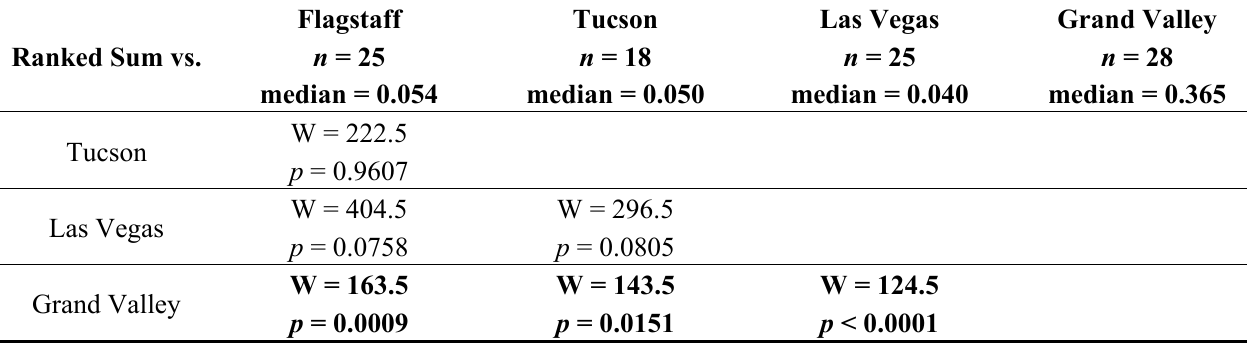
Table 11. Wilcoxon ranked sum test on normalized weighted degree distributions, pairwise among all data sets in Figure 7. Significant test results shown in